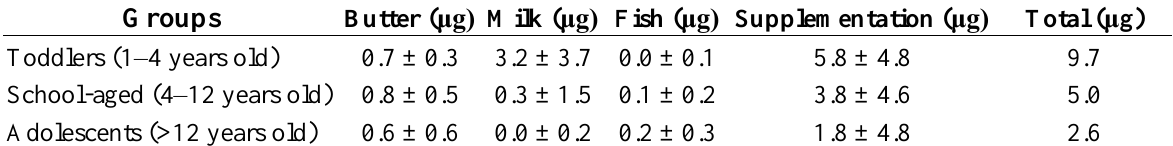
Table 2. Mean and standard deviation of daily intake of vitamin D per nutrient for three age